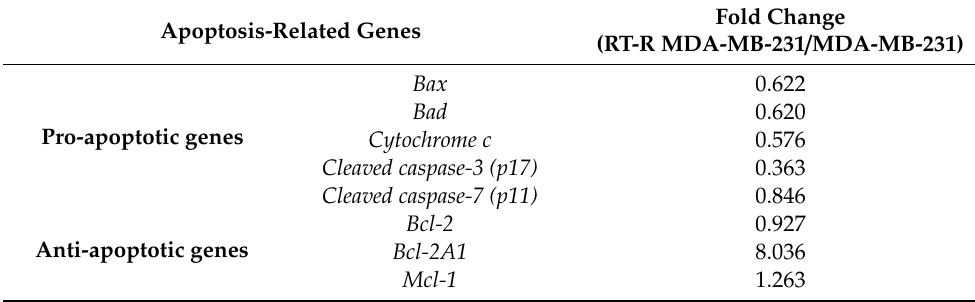
Table 1. Analysis of gene expression levels between MDA-MB-231 and radiotherapy-resistant (RT-R) MDA-MB-231 cells. Total RNA was extracted from MDA-MB-231 and RT-R MDA-MB-231 cells, and the genes involved in apoptotic cell death were